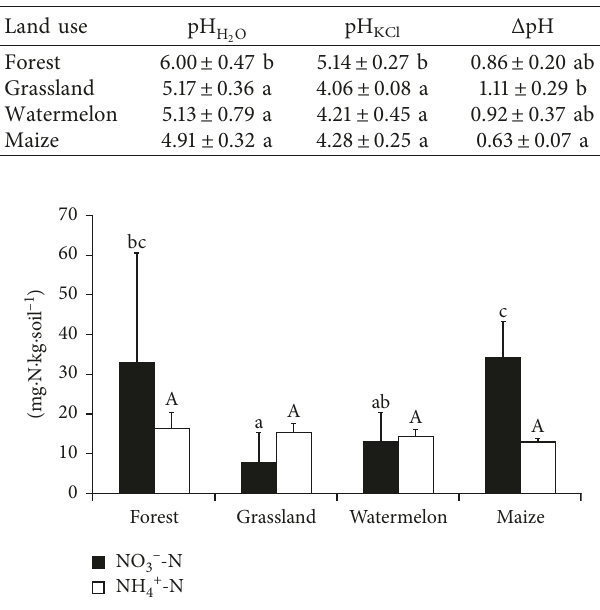
Figure 2: Mean SD soil contents of NO 3 -N and NH 4+ -N under different land use types. Different letters above the bars indicate − significant differences in NO 3 -N (lowercase letters) and NH 4+ -N ± (uppercase letters) among land use types (one-way ANOVA, − p 0 . 05) ( n 2 , 4 , 3 , and 2 for forest, grassland, watermelon, and (cid:30) maize sites, <